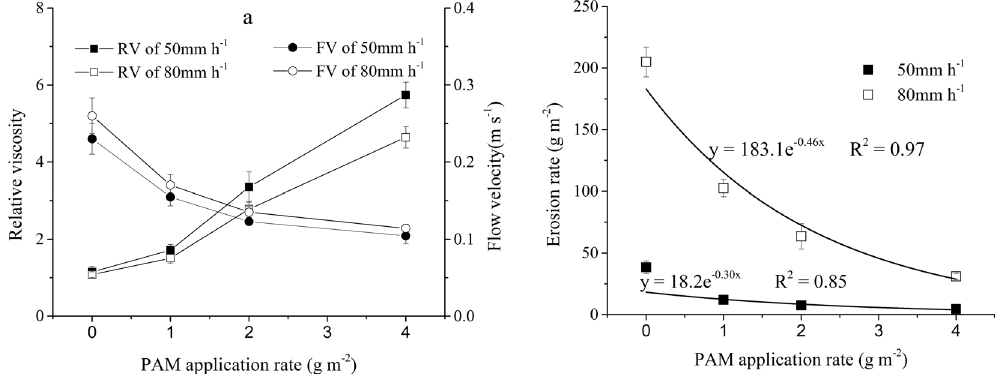
Figure 3. ( a ) Relative viscosity in the runoff and flow velocity of a slope associated with different treatments, error bars = standard deviation. ( b ) The erosion rate as a function of PAM application under 50 and 80 mm·h − 1 rainfall intensities. Symbols = data; lines = fitted regressions; error bars = standard deviation.